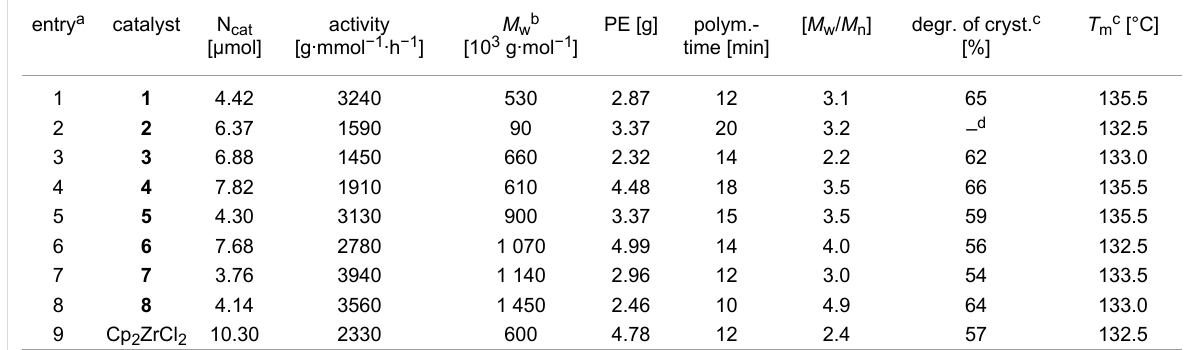
Table 1: Results of the ethylene-polymerization tests with complexes 1–8 and Cp 2 ZrCl 2 as catalyst precursors. entry